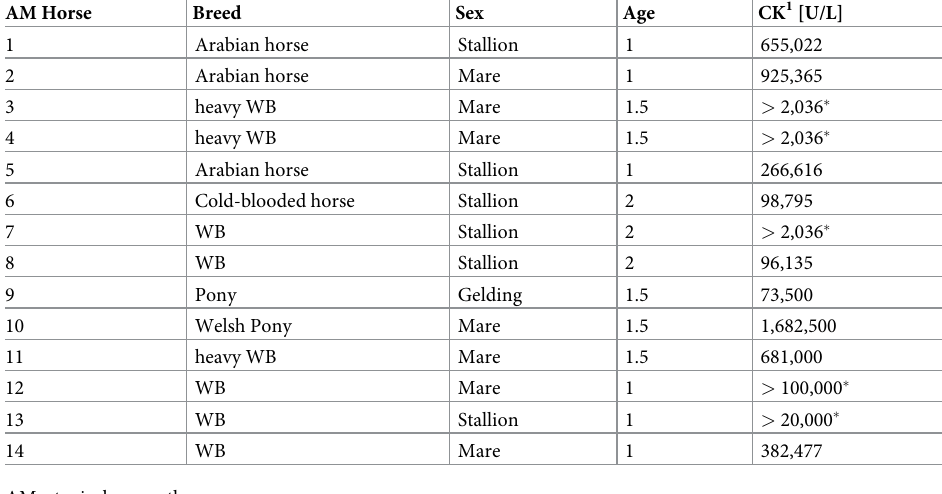
Table 1. Specific characteristics (breed, sex, age and creatinine kinase activity) of AM affected horses. AM Horse